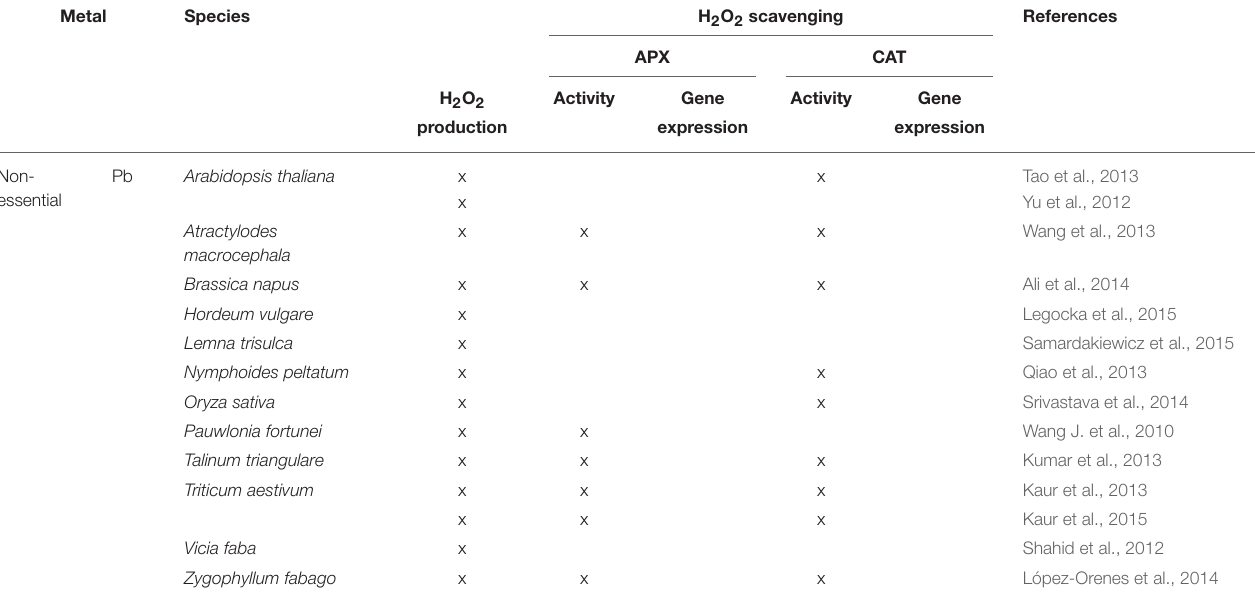
( Figure 2 ; Mittler, 2002). As shown in Table 1 , both H 2 O 2 scavenging enzymes are affected at transcriptional and activity level in metal-exposed plants. For example, Cuypers et al. (2011) demonstrated differential effects of Cd and Cu on CAT and APX gene expression in Arabidopsis thaliana plants. Dependent on the metal concentration and isoform considered, expression levels were specifically affected in roots or leaves. Furthermore, expression changes were not always mirrored by the enzyme activities, suggesting that CAT and APX regulation also occurs at the post-transcriptional level under metal stress (Cuypers et al.,